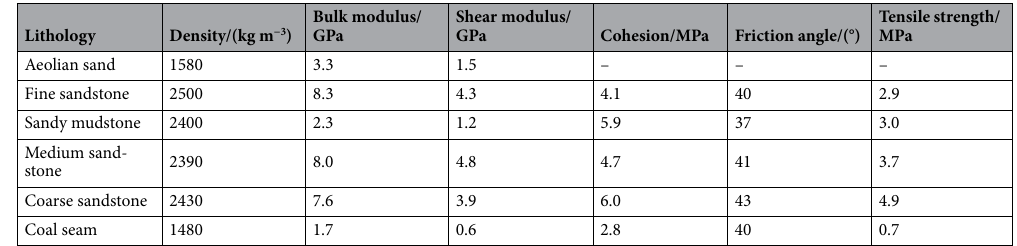
Table 1. Physical and mechanical parameters of coal and rock strata.